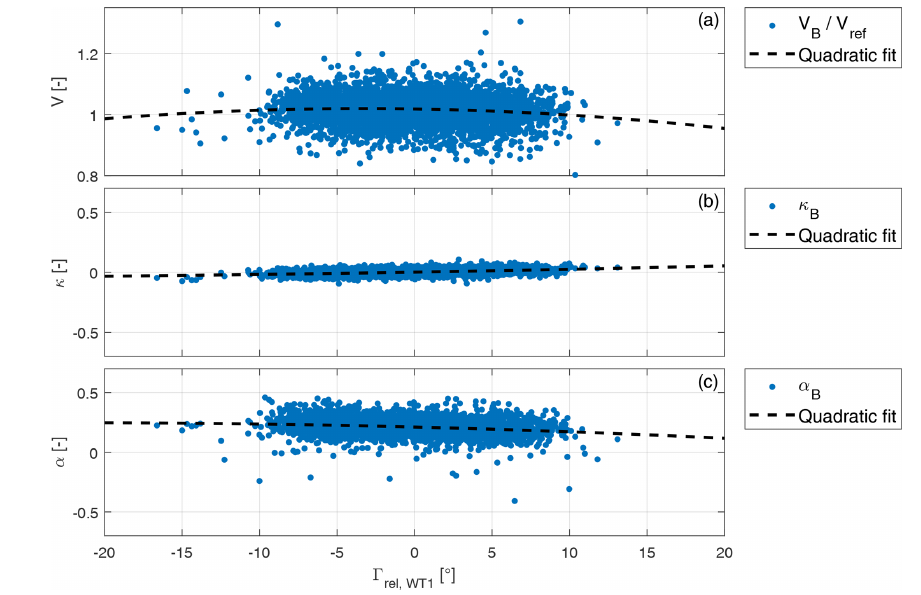
Figure 15. From top to bottom: rotor-effective wind speed V B , horizontal shear κ B , and vertical shear α B , all plotted as functions of wind turbine misalignment angle (cid:48) rel , WT1